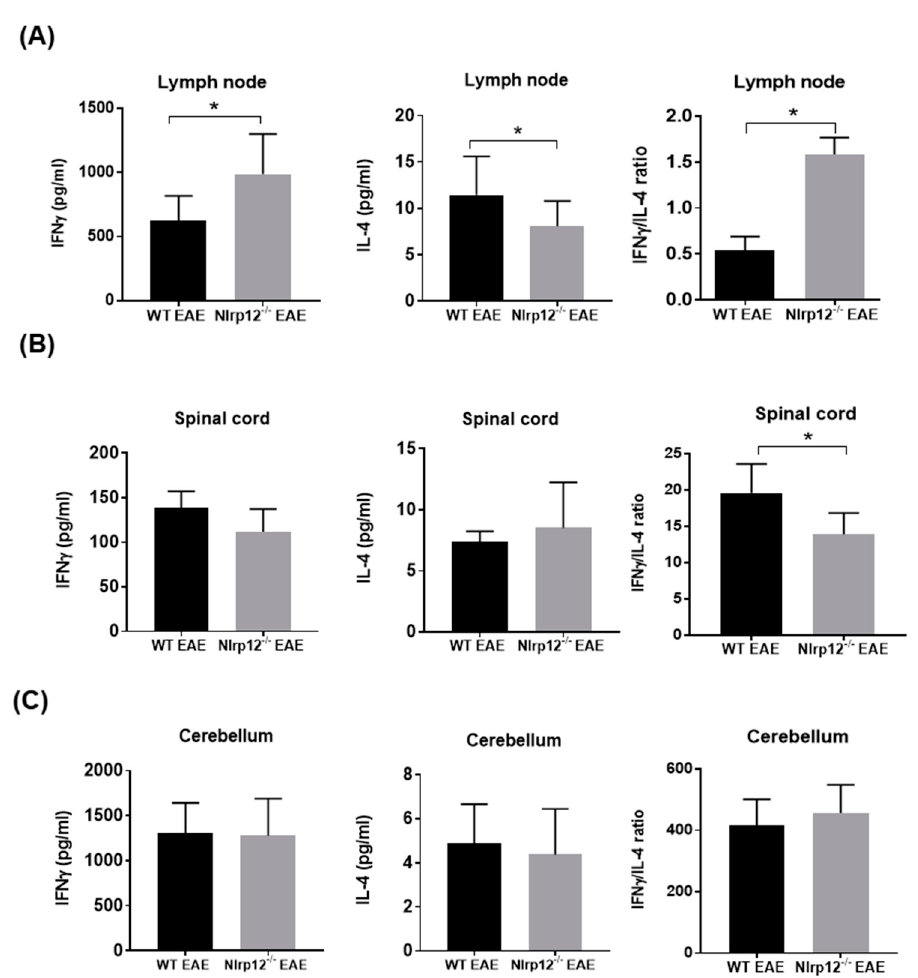
Figure 1. Nlrp12 inhibits Th1 response in Experimental Autoimmune Encephalomyelitis (EAE). Th1- and Th2- related cytokines in tissue lysates from EAE mice. Central nervous system (CNS) tissues and lymph nodes were collected from EAE mice after 3 weeks of immunization with myelin oligodendrocyte/complete Freund’s adjuvant (MOG/CFA). The tissues were homogenized in lysis buffer and cytokine levels were measured in tissue lysate by ELISA. ( A ) The levels of IFN γ , IL-4 and IFN γ /IL-4 ratio in lymph node extracts from WT and Nlrp12 − / − EAE mice; ( B ) The levels of IFN γ , IL-4 and their ratios in the spinal cord and ( C ) cerebellum of EAE mice, n = 5–6 per group, * p < 0.05.